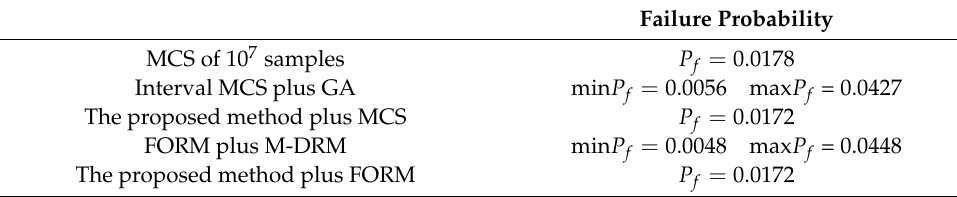
Table 4. Results comparison of the different